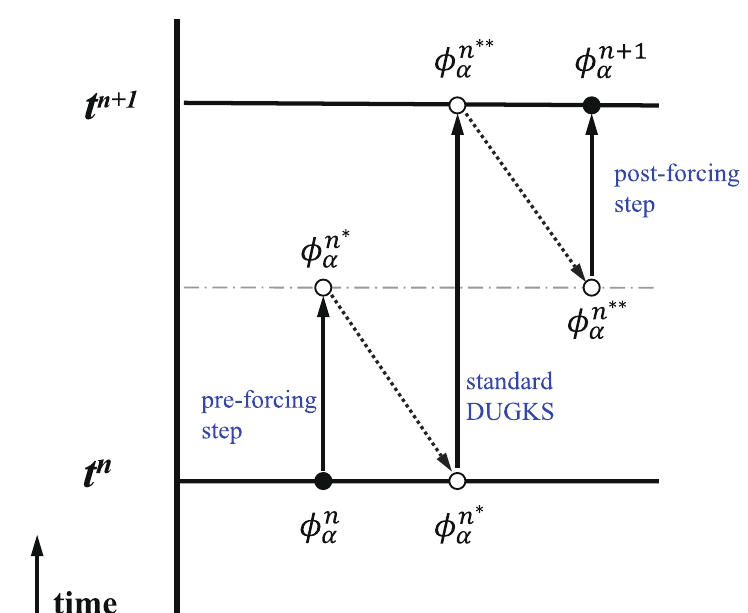
Fig. 1 The evolution of the Strang-splitting method from time t n to t n +